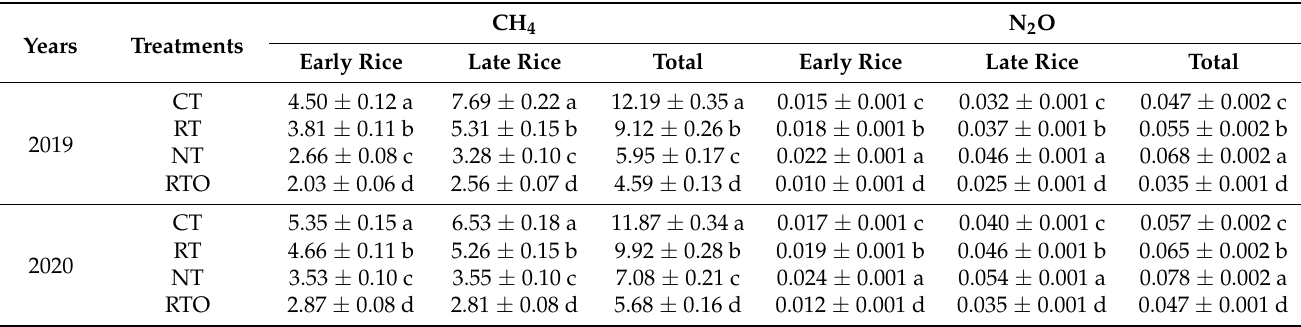
Table 2. Impacts of different short-term tillage managements on CH 4 and N 2 O emissions from double-cropping rice field (g m − 2 ).